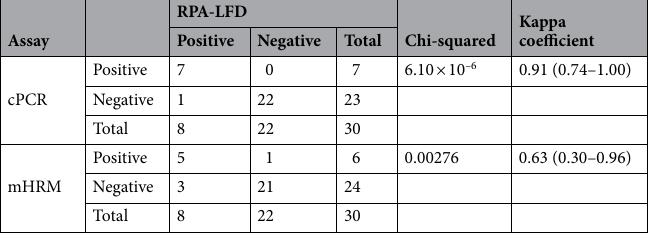
Table 2. Comparative performances of RPA-LFD to cPCR and RPA-LFD to mHRM assays for Babesia spp.